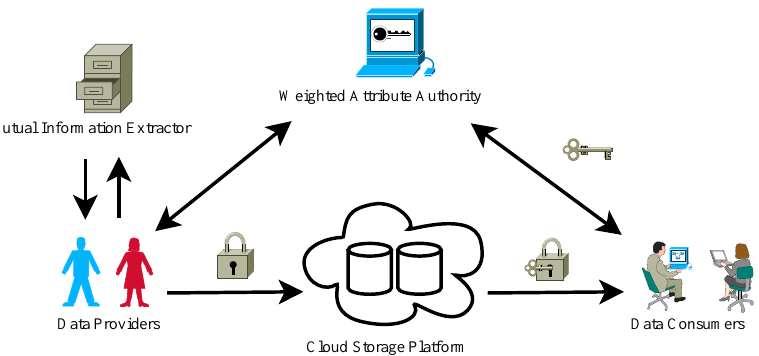
Figure 2. System model of